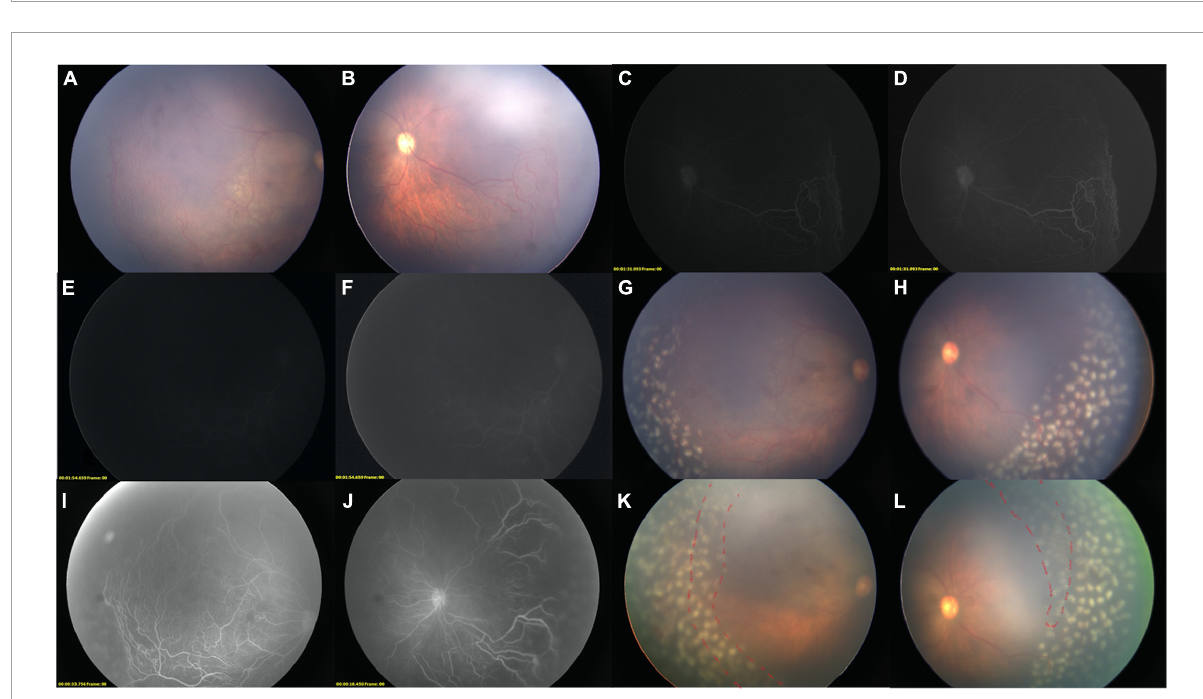
FIGURE2 Two-step FFA-guided relaser of an IP child. Color images of the right eye before FFA [ (A) Temporal field; (B) Nasal Field]. LD-FFA [ (C) : 1 m 35 s, (D) : Adjusted version of (C) ; (E) : 1 m 54 s, (F) adjusted version of (E) ] showed supernumerous vascular branching, vessels dilatation, vessels tortuosity, and peripheral avascular zone in the nasal field (D) , while not so clear in the temporal side (E,F) . (F) Showed filling of optic disk and sparse posterior retinal vessels. (G,H) Color images after laser ablations, the media was clean enough without green stain by the fluorescein. (I,J) Step-two RD-FFA reveals all the abnormal vessels, non-perfusion areas, and previous laser spots. (K,L) After comparisons, supplementary laser photocoagulation was immediately applied (red dashed line), while the vitreous is greenish due to dye extravasation after RD-FFA.